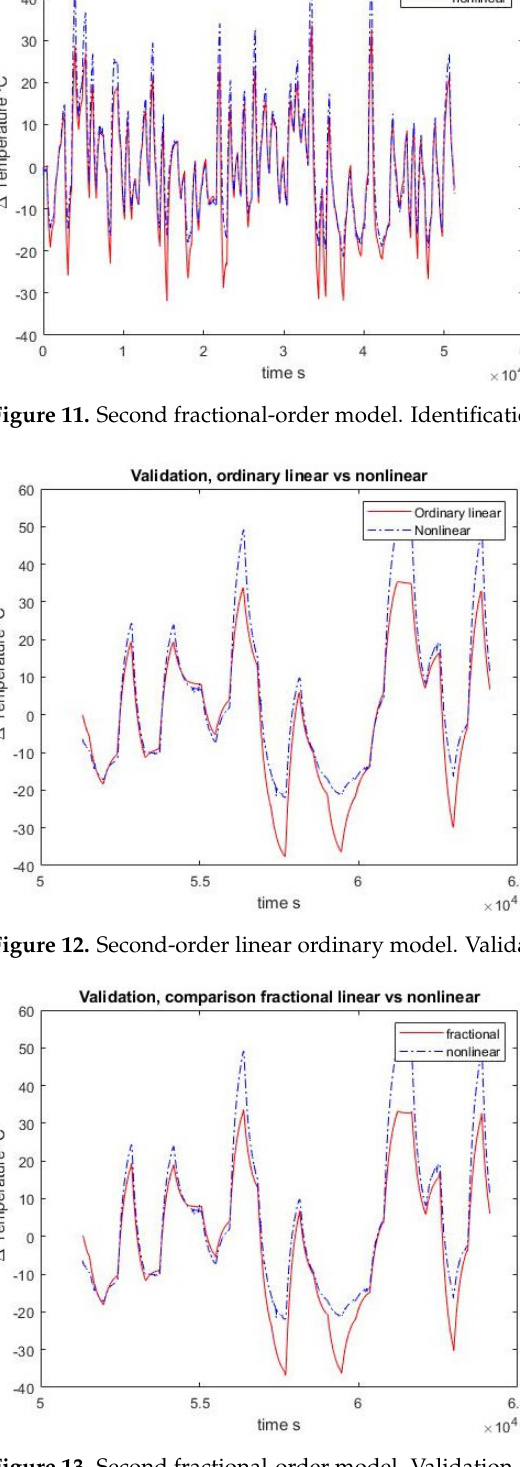
Figure 13. Second fractional-order model.